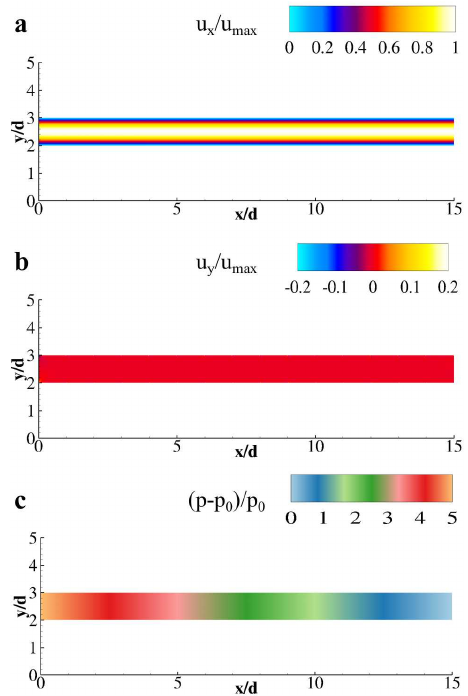
Figure A1. Flow patterns in the l / d = 1 micro-channel. ( a ) contour of the longitudinal component of the velocity field; ( b ) contour of the vertical component of the velocity field; ( c ) relative pressure distribution in the computational flow field ( p 0 is the outlet section